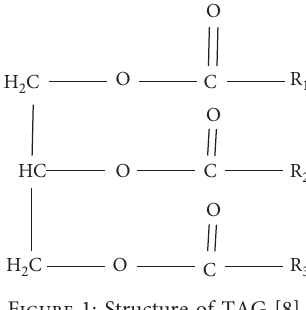
Figure 1: Structure of TAG